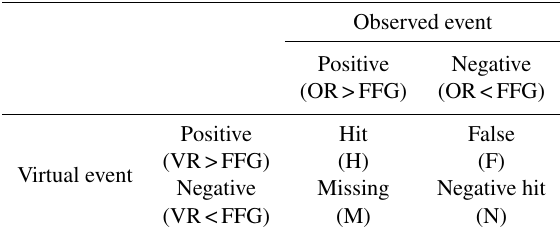
Table 2. ROC analysis for quantitative precipitation